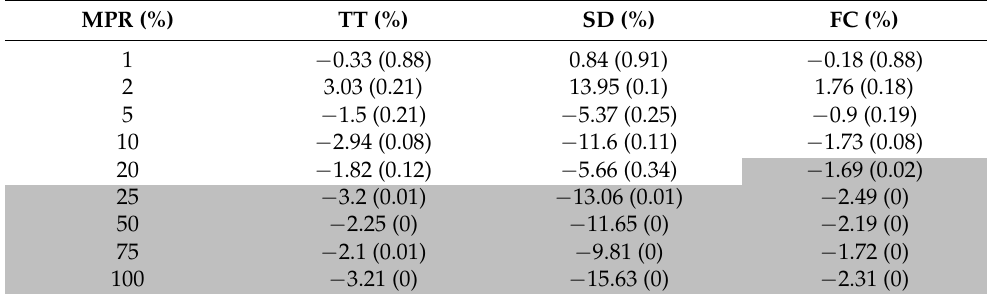
Table 1. The percentage change between the C-V2X and IDEAL-based C-EEDR applications perfor- mance in terms of Travel Time (TT), Stopped Delay (SD) and fuel consumption. MPR (%) TT (%) SD (%) FC (%) 1 − 0.33